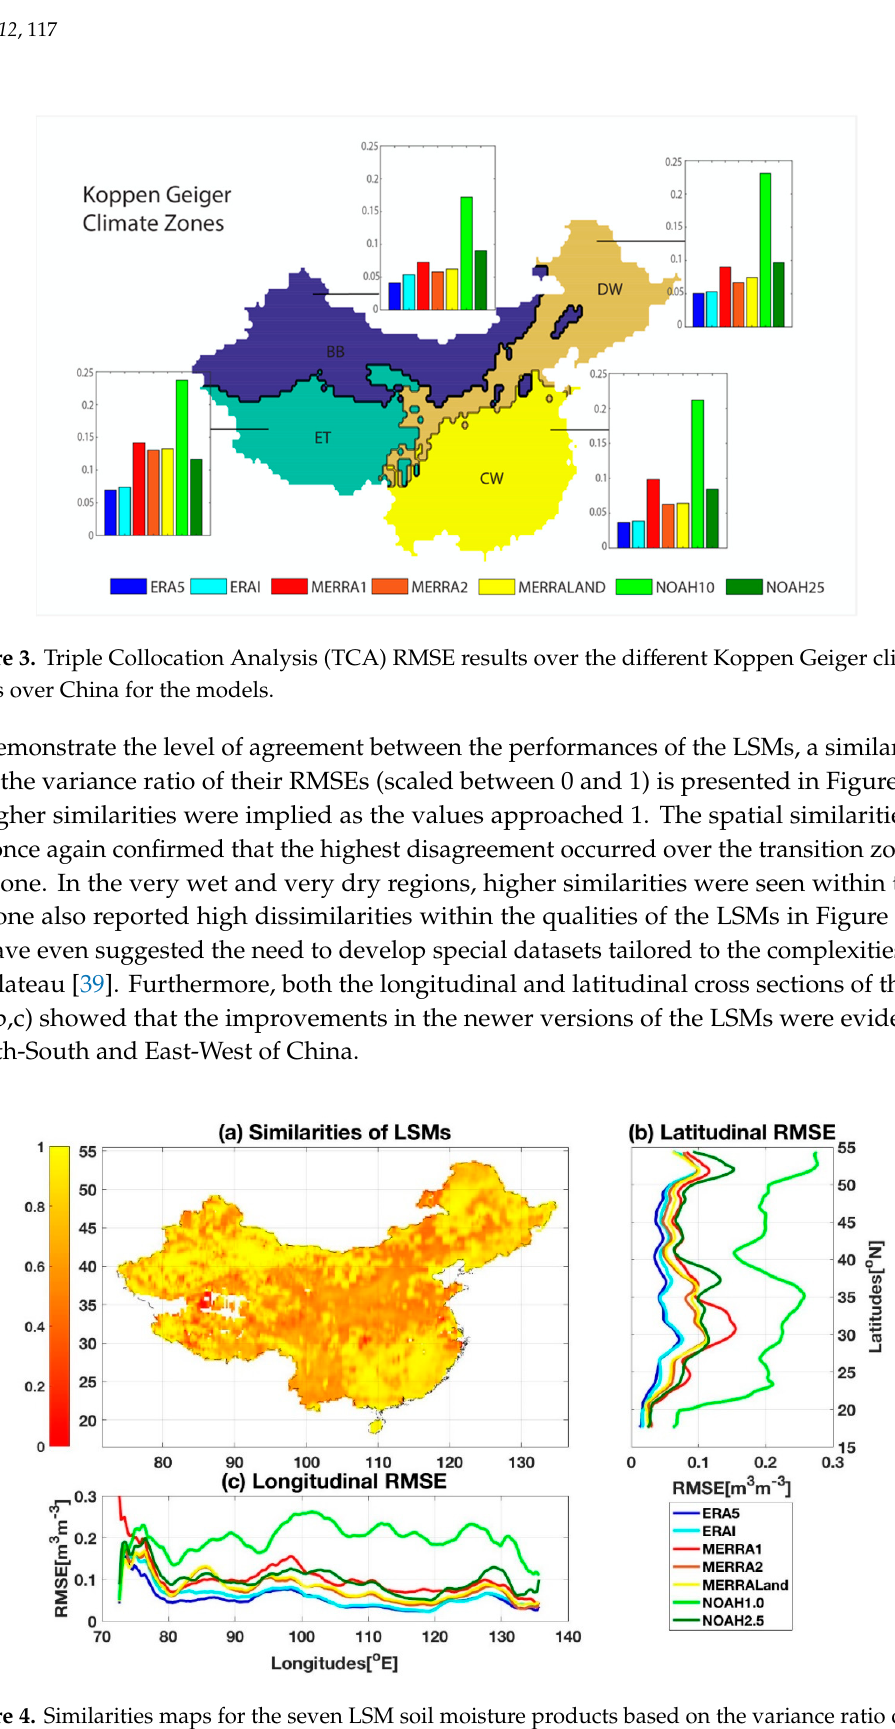
Figure 4. Similarities maps for the seven LSM soil moisture products based on the variance ratio of the TCA RMSEs. ( a ) shows similarities over the entire region, ( b ) shows the longitudinal RMSEs and ( c ) shows the latitudinal RMSEs.